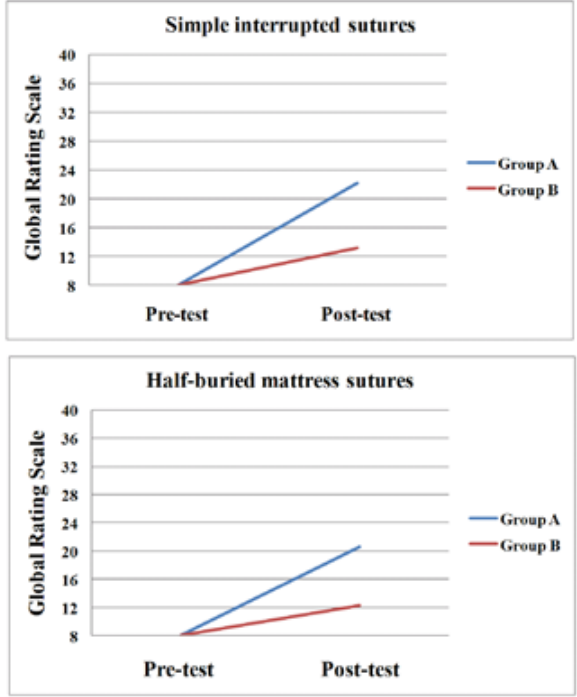
FIGURE 3 – Mean of the all ( left ) simple interrupted suture performances and ( right ) half-buried mattress suture performances pre-and post-tests based on Global Rating Scale. Both groups A (Ethylene-vinyl acetate bench model) and B (Control) showed better suture performances in the post-test when compared with the pre-test (p<0.05), but the group A improved their suture performances significantly more (p<0.05) than did group